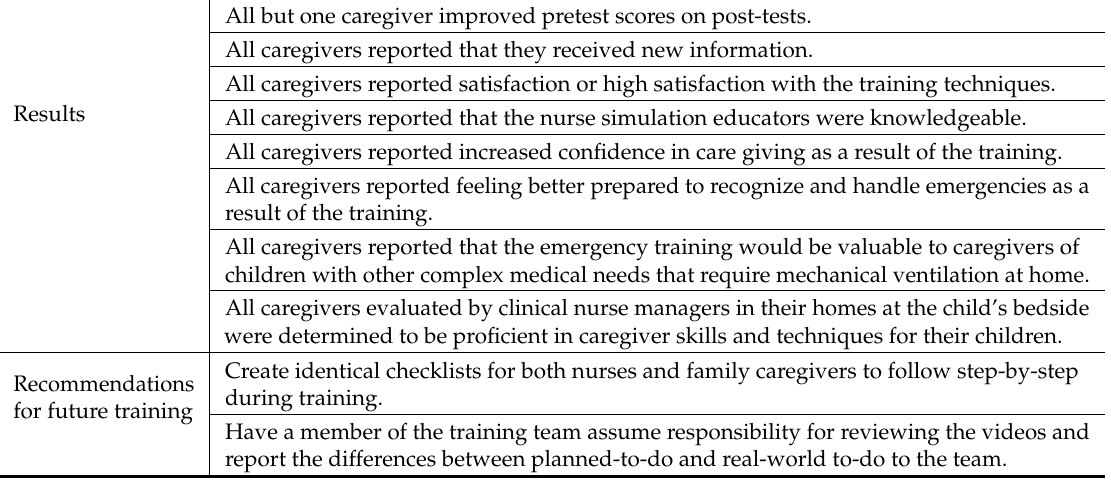
Table 3. Test and survey